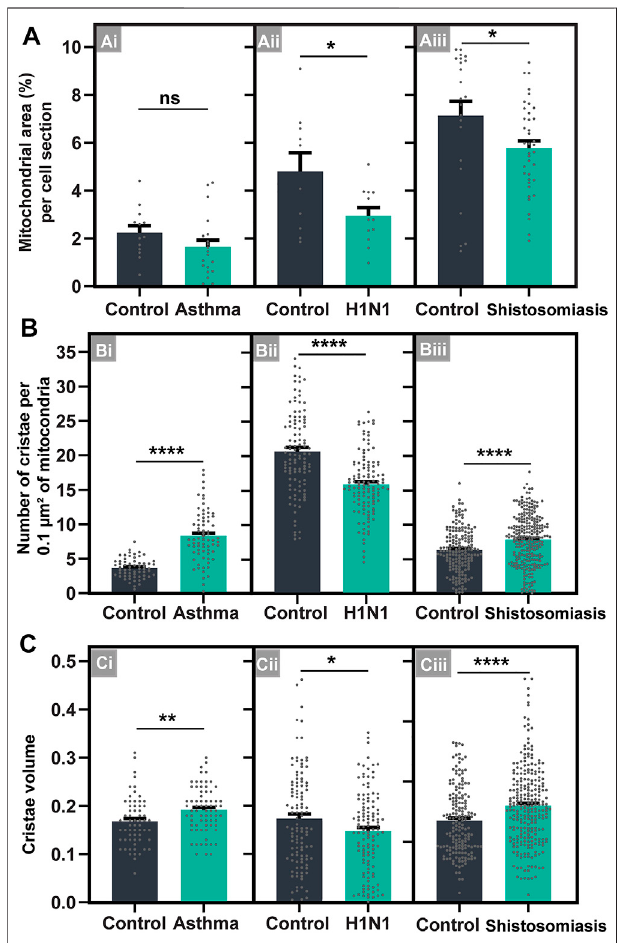
FIGURE 7 | In fl ammatory diseases induce consistent mitochondrial cristae remodeling within in fi ltrating tissue eosinophils in mice. (A) The total mitochondrialareaintheeosinophilcytoplasmdidnotchangeinasthma(Ai)or is reduced in H1N1 IAV infection (Aii) and schistosomiasis mansoni (Aiii), in response to the in fl ammatory diseases. (B,C) The total number (B) and volume (C) of cristae is increased in both asthma (Bi and Ci) and schistosomiasis (Biii and Ciii), but not in the H1N1 IAV infection (Bii and Cii). Samples were prepared for TEM and quantitative analyses performed using Fiji software. Scattered dots represent single-cell data in (A) ; 0.1 µm 2 of the mitochondrial area in (B) ; and single mitochondria data in (C) . A total of 795 mitochondria were evaluated at high resolution within 116 cells collected from at least fi ve independent experiments for each condition. Cells were prepared forTEM.Resultsareexpressedasmeans±SEM(* p < 0.05;** p < 0.01;**** p < 0.0001; ns (not signi fi cant) p > 0.05).